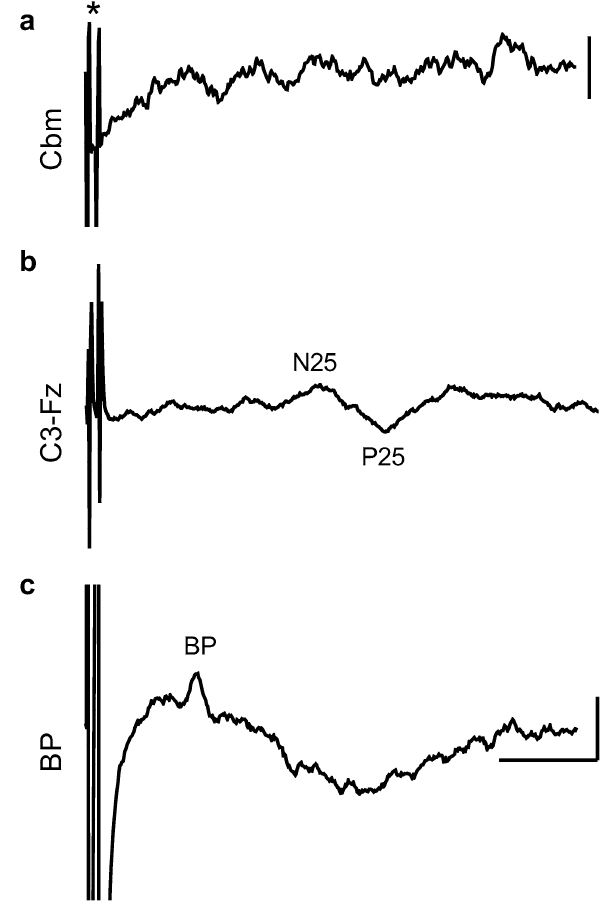
Figure 2. Example results from one patient (S4) with stimulation of the median nerve. ( a ) Stimulus artefact indicated by (*) but no detectable cerebellar (Cbm) response was evident. Average of 30 trials. ( b ) Cerebral SEPs (N25 and P25) recorded with a scalp electrode (C3) placed posterior to the central midline over the lateral parietal lobe, referenced to the Fz electrode placed over the frontal midline. ( c ) Brachial plexus (BP) peripheral nerve response. All SEP traces based on average of 50trials. Voltage scale bars = 10 µV in ( a–c